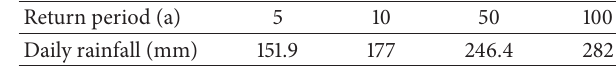
Table 3: The table of recurrence interval and